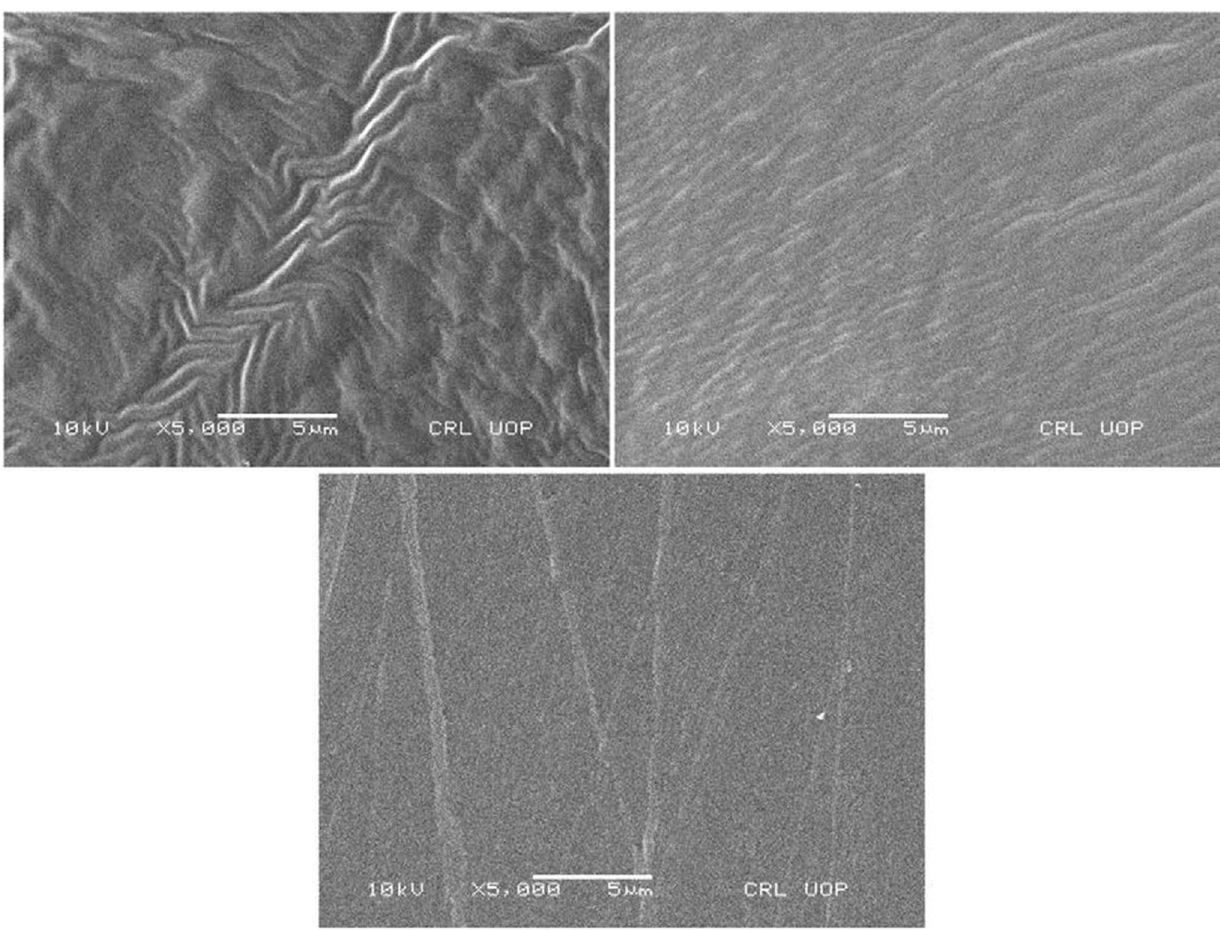
Fig. 2 SEM images of pure chitosan of different